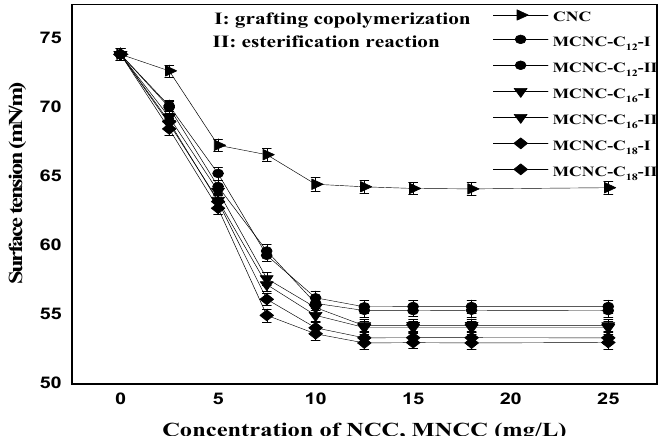
Figure 7. Effect of MCNC concentration on surface tension of MCNC suspension.